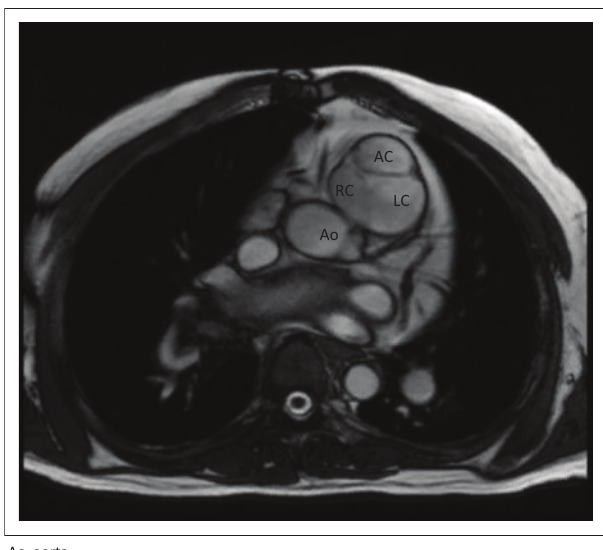
FIGURE 4: Axial cine SSFP image through the pulmonary valve demonstrates the three cusps of the pulmonary valve: the anterior (AC), right (RC) and left (LC)